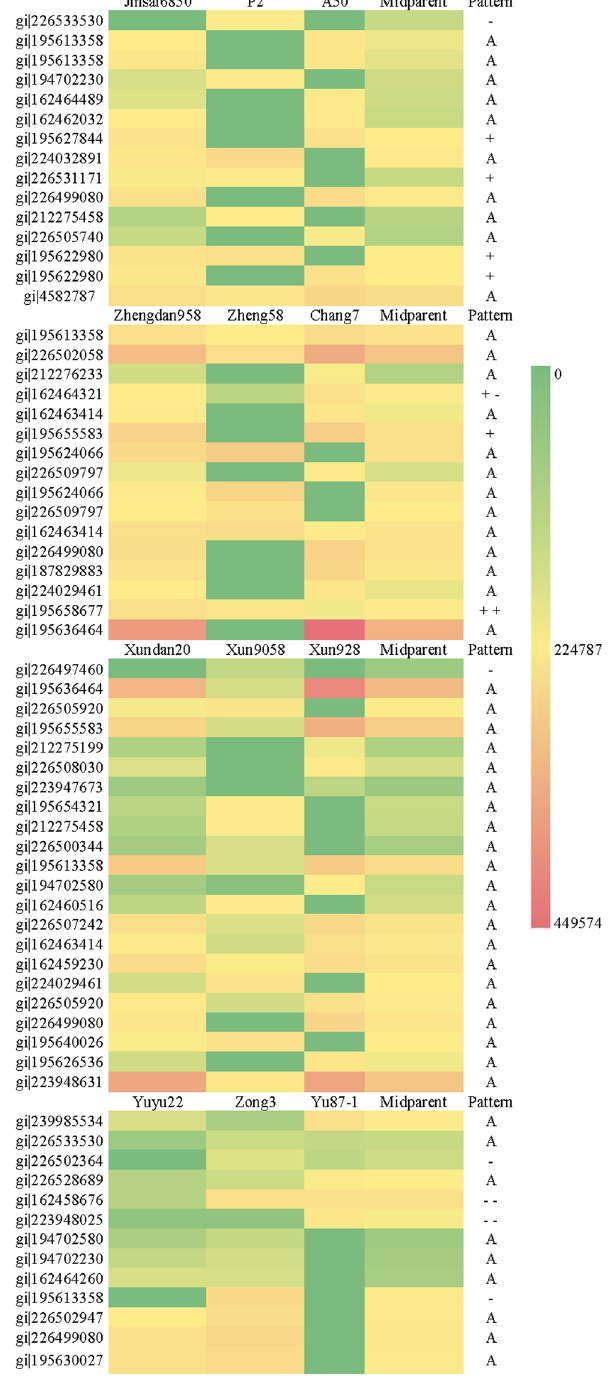
Figure 4. Heat map and abundance patterns of differentially accumulated proteins in the eighth internode of the hybrids and parental lines. Note: Differences in accumulation are presented as a continuous range of colours. Red corresponds to the maximum accumulation (grey value: 449574); green corresponds to the minimum accumulation (grey value: 0); and yellow corresponds to the median accumulation (grey value: